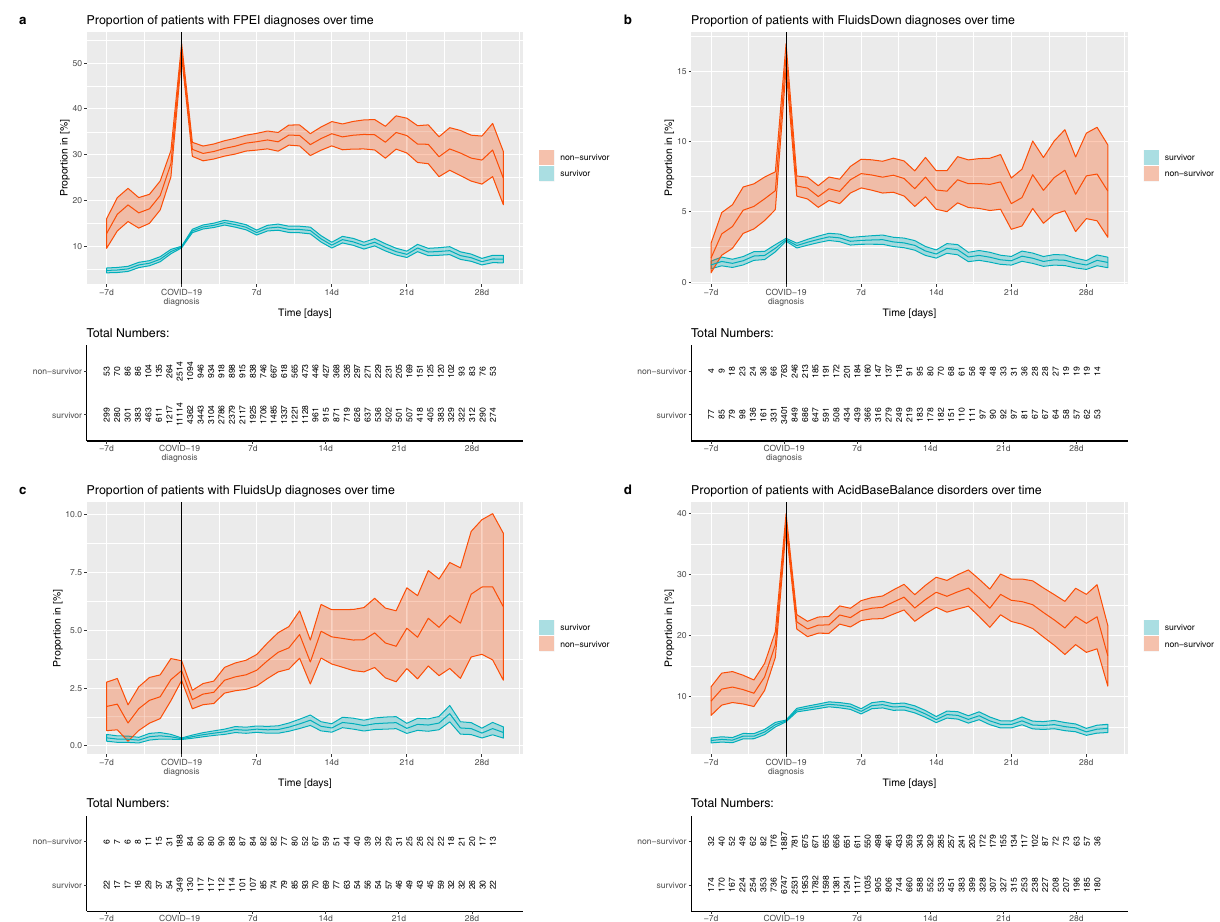
Fig. 4 Cumulative incidence of fl uid, pH, and electrolyte imbalance (FPEI) diagnoses assigned before and during COVID-19, separated by survivor versus non-survivor status. Proportion of patients having diagnoses associated with a any FPEI b fl uid/volume de fi cit, ICD-10 codes E86.0, E86.1 or E86.9 c fl uid/volume overload, ICD-10 codes E87.70 or E87.79 or d acid/base imbalance, ICD-10 codes E87.2, E87.3, E87.4, E87.5 or E87.6. The plot is split by survivor (cyan) versus non-survivor (orange) status. The underlying variable is a one-hot-encoded binary variable that indicates presence or absence of the comorbidity at the time point, “ 1 ” indicating presence, “ 0 ” indicating absence. The line shows the mean of the variable, i.e., the cumulative incidence. The standard error is shown as a shaded area around the mean, and indicates the sampling error. Plotted over days -7 … + 30 with respect to the COVID-19 diagnosis date. Non-survivors with an estimated death date before day + 7 were excluded. For the N = number of patients with data available on each day, see the inserts in the fi gure